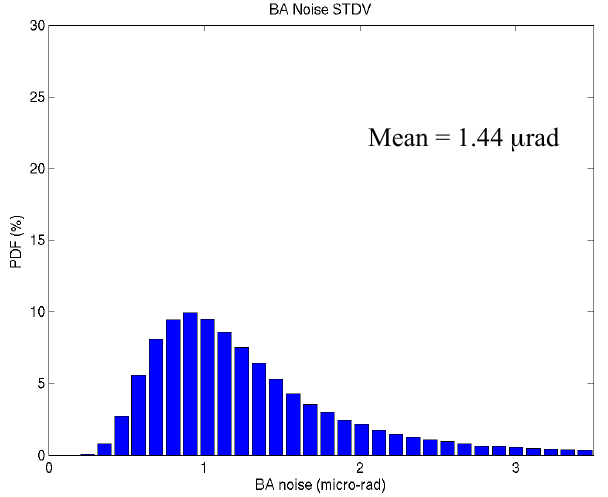
Fig. 15. Distribution of standard deviation of bending angle noise for ∼ 162000 F3C profiles that used clock reference satellite data acquired on the same side of the F3C satellite as the occulting satel- lite data.